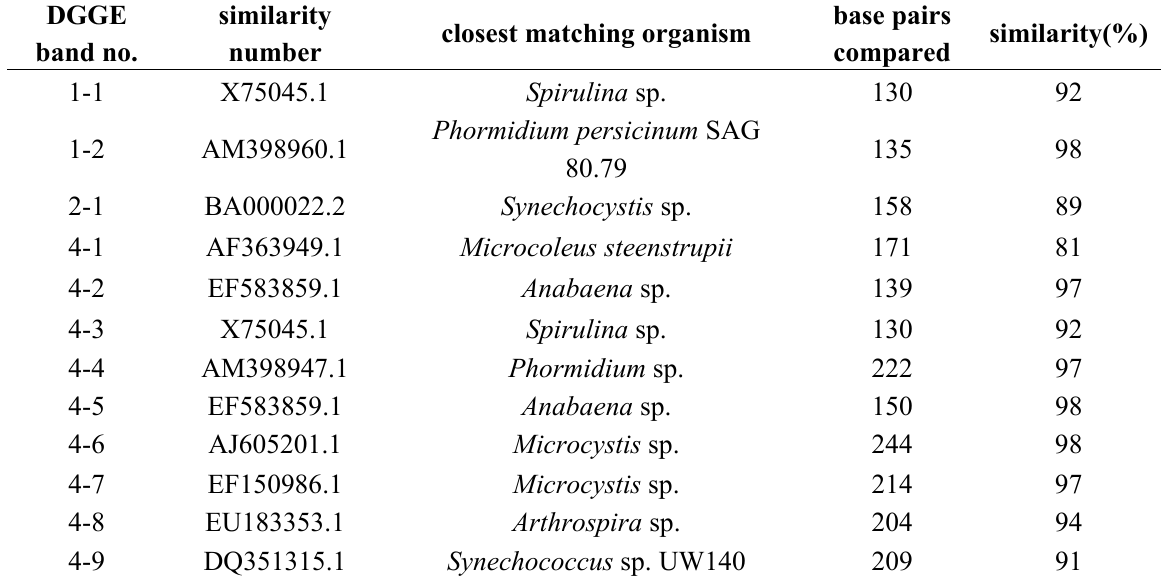
Table A1. List of sequencing results from DGGE bands on Figure A1. DGGE band